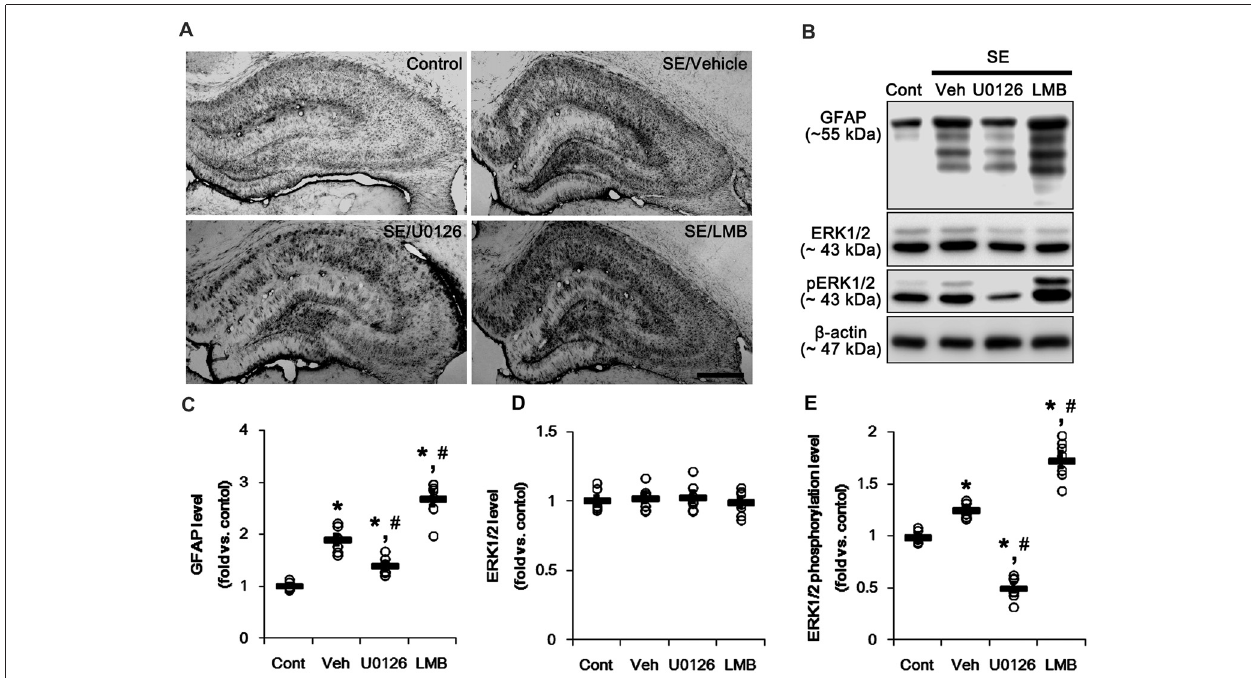
FIGURE 1 | Effects of U0126 and leptomycin B (LMB) on glial fibrillary acidic protein (GFAP), extracellular signal receptor activated kinases 1/2 (ERK1/2) and phospho (p)-ERK1/2 level in the hippocampus following status epilepticus (SE). (A) Representative images for GFAP expression in the hippocampal tissues. As compared to vehicle, U0126 increases GFAP expression, while LMB reduces it. Bar = 400 µ m. (B) Representative images for western blot images of GFAP, ERK1/2 and pERK1/2 levels in the hippocampal tissues. (C–E) Quantifications of GFAP (C) , ERK1/2 (D) and pERK1/2 (E) intensity. Open circles indicate each individual value. Horizontal bars indicate mean value. Error bars indicate SEM ( ∗ , # p < 0.05 vs. control and vehicle, respectively; n = 7,